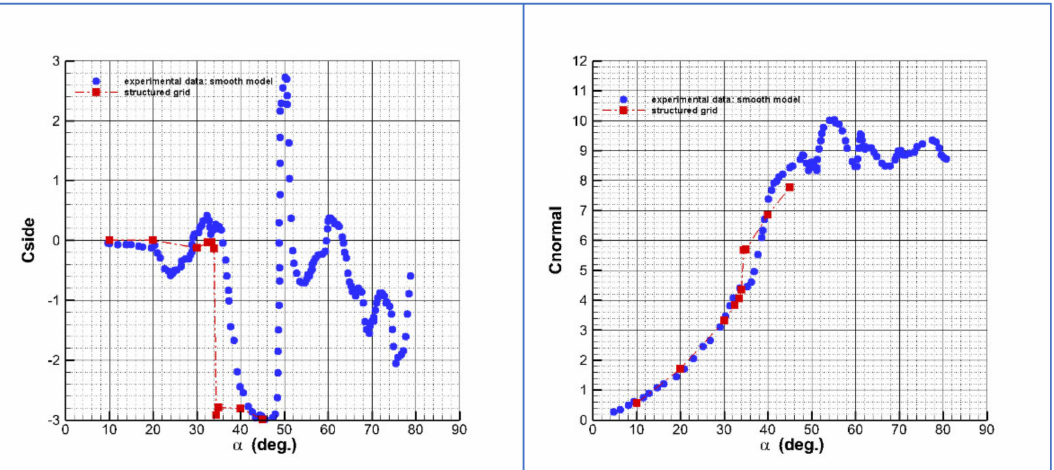
Figure 12. ( Left ) side force coefficient versus angle of attack. ( Right ) normal force coefficient versus angle of attack. Ma = 0.2, Re = 2 × 10 6 . Grid S1 solutions (red squares) compared to experimental data (in blue dots) for the smooth